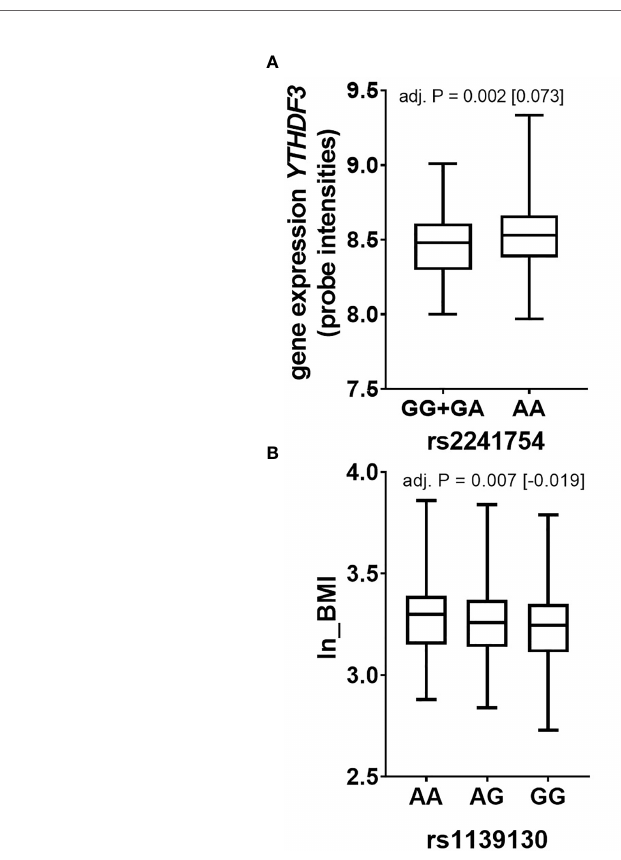
FIGURE 5 | Genetic variation in YTHDF3 and METTL3 associates with expression and BMI respectively (Sorbs cohort). Data are presented as boxplots with median and quartile distribution for SNPs in (A) YTHDF3 and (B) METTL3 . P -values were calculated by using linear regression analyses adjusted for age, sex and BMI (except for ln_BMI) by using an additive or dominant mode of inheritance. Numbers of subjects per SNP are as following: METTL3 : rs1139130 AA=209, AG=390, GG=241; rs2242526 GG=151, GC=415, CC=274; YTHDF3 : rs2241754 AA=733, GG+GA= 107; rs1435457 CC=586, AA+AC=254. P = P -value; BMI-body mass